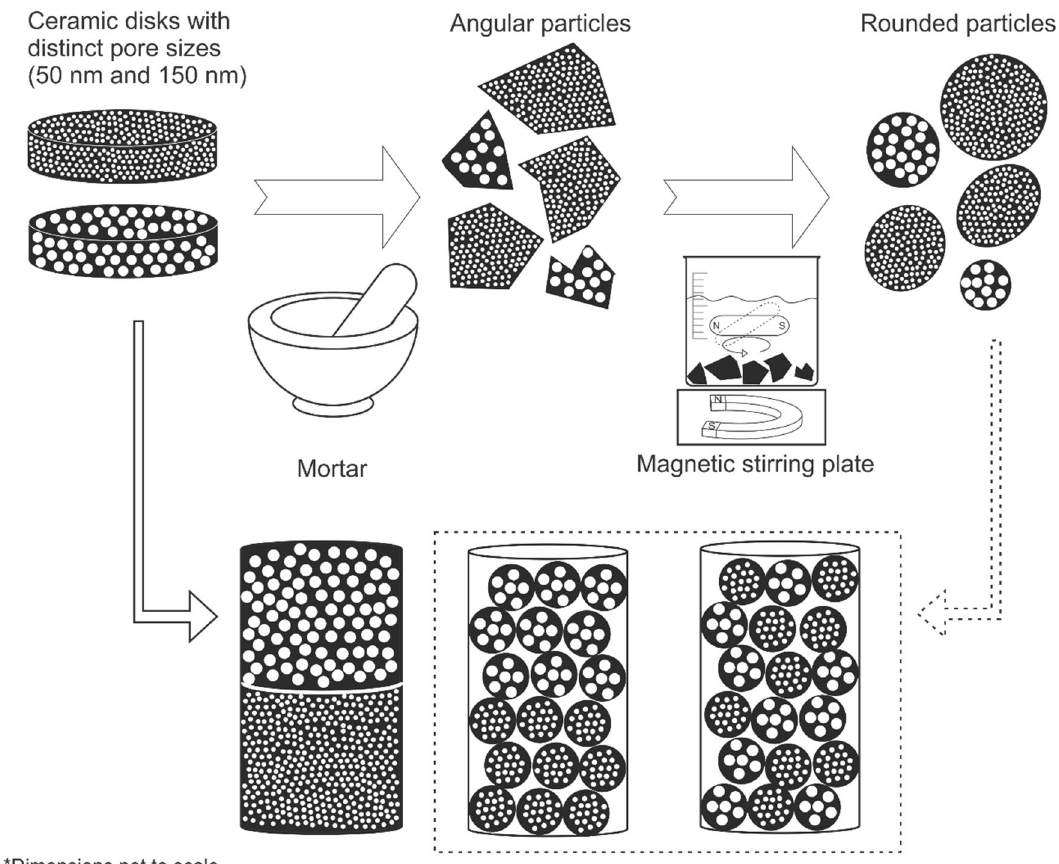
Figure 13. Process to create the three samples consisting of either single larger subsamples of the ceramic disks, smaller grains that were kept separated, or smaller grains that were mixed together. For the samples with the grains, ceramic disks were crushed in a mortar, and the particles were rounded and smoothed using the procedure described by Nasir et al. 41 . Black = alumina material. White =